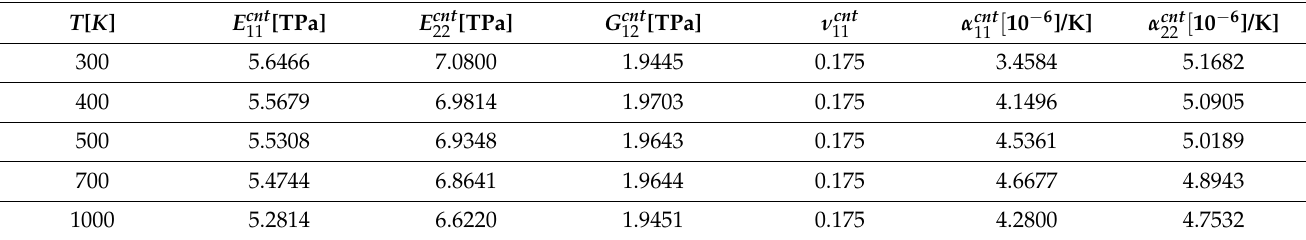
Table 2. Thermo-mechanical properties of